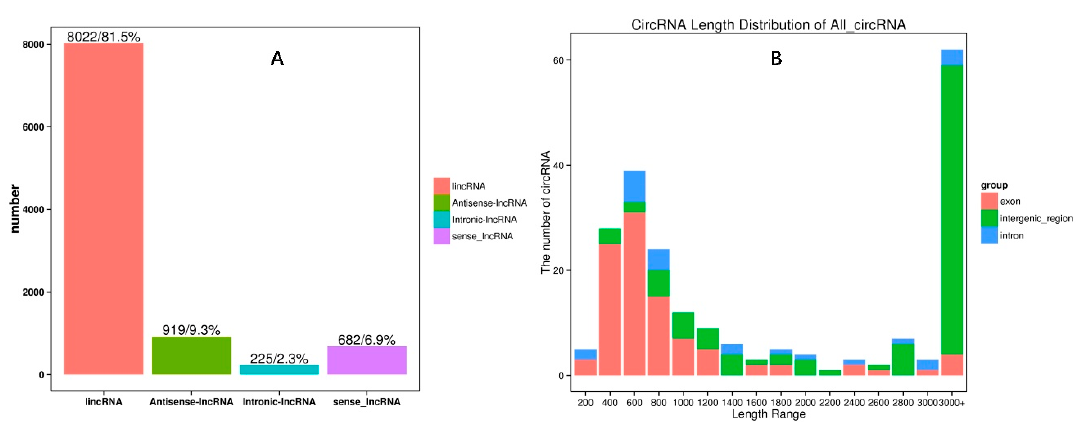
Figure 1. The four kinds of long non-coding RNAs (lncRNAs) were: long intergenic noncoding RNAs (lincRNAs) (8022, 81.5%), antisense-lncRNAs (919, 9.3%), sense lncRNAs (682, 6.9%), and intronic-lncRNAs (225, 2.3%) ( A ).